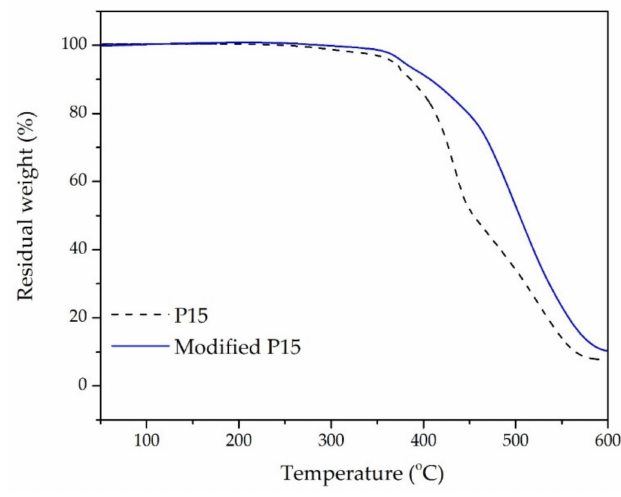
Figure 12. Thermogravimetric (TGA) curves of the P15 and the modified P15.